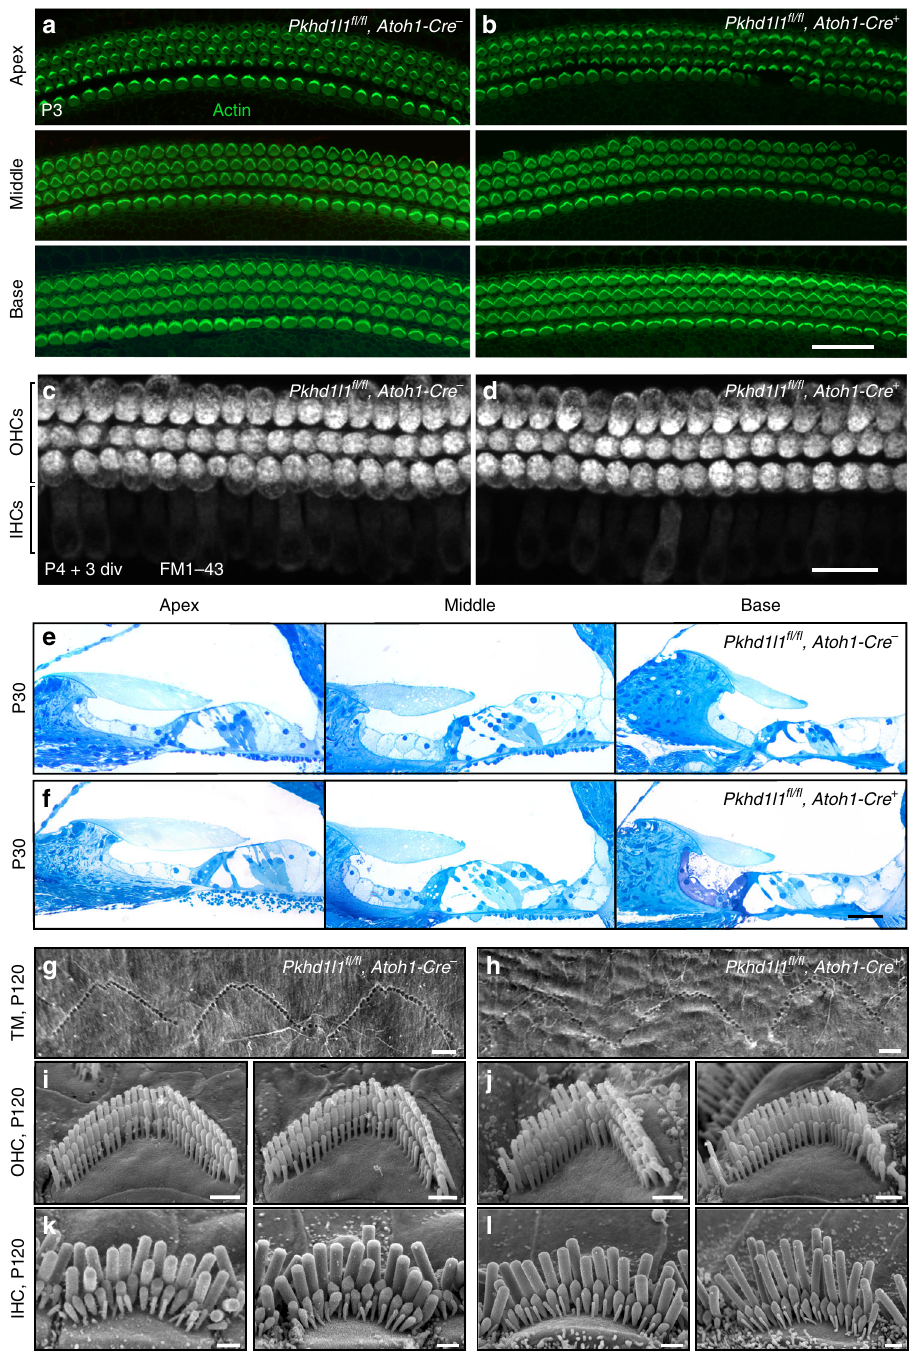
Fig. 6 No gross de fi cit in bundle morphology or mechanotransduction in Pkhd1l1 fl / fl , Atoh1-Cre + mice. a , b Hair-cell planar cell polarity appeared normal at P3 in the apical, middle, and basal turns of both mutant Pkhd1l1 fl / fl , Atoh1-Cre + mice b and control Pkhd1l1 fl / fl , Atoh1-Cre − littermates a . c , d PKHD1L1- de fi cient P4 + 3-days-in-vitro hair cells accumulate FM1-43. e , f Semithin plastic sections stained with methylene blue show no gross morphology de fi cit in the organ of Corti. In both groups at P30, the TM appears slightly retracted from the OHCs, likely an artifact of tissue preparation. g , h SEM photomicrographs of OHC stereocilia imprints on the surface of the TM. Basal turn, age P120. i – l SEM photomicrographs of Pkhd1l1 fl / fl , Atoh1-Cre − i , k , and Pkhd1l1 fl / fl , Atoh1-Cre + j , l IHC and OHC stereocilia bundles at P120. Scale bars: a , b 30 µ m; c , d 20 µ m; e , f 500 µ m; g – l 1 µ